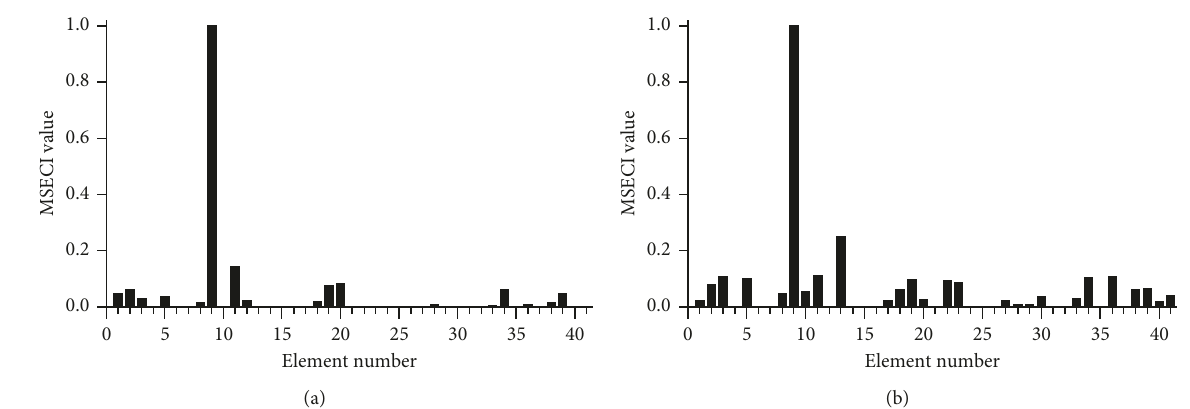
0.00.20.40.60.81.0 Figure 8: Values of the proposed MSECI using modes 1, 4, 6, 8, 9 (damaged element 9). (a) Without noise. (b) With 5% noise. 0.00.20.40.60.81.0 Figure 9: Values of the proposed MSECI using modes 4, 8 (damaged element 9). (a) Without noise. (b) With 5%